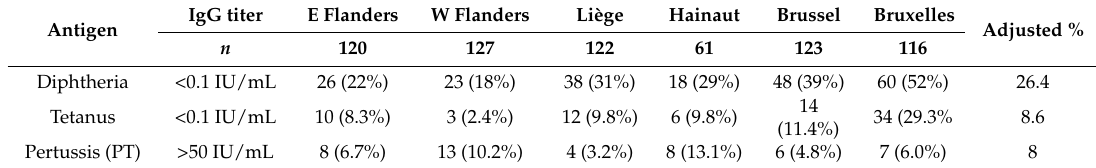
Table 3. Number and percentage of subjects with serum concentrations below protection levels for diphtheria and tetanus and with serum levels indicative of pertussis infection during the last few